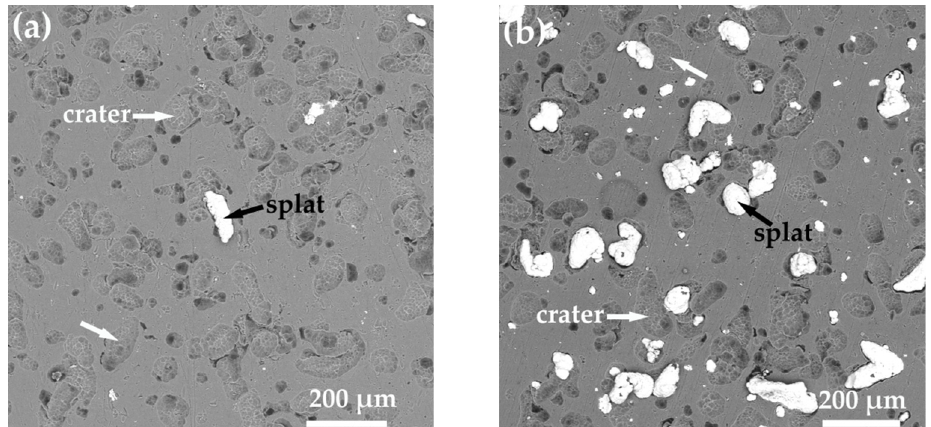
Figure 8. Morphologies of Ni-coated Al particles deposited onto an Al substrate at an accelerating gas temperature of ( a ) 200 °C and ( b ) 400 °C.